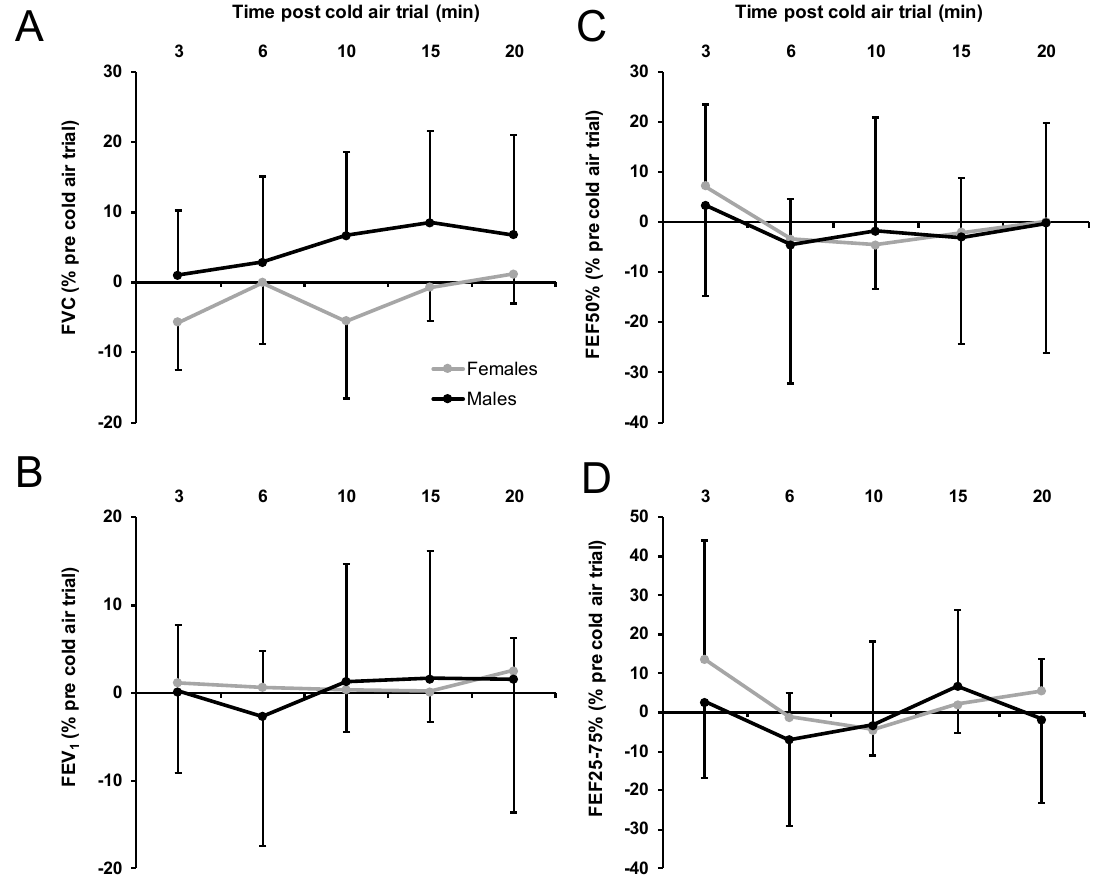
Figure 3. Acute respiratory recovery variables at 0 °C FVC ( A ), FEV 1 ( B ), FEF50% ( C ), FEV25–75% ( D ) expressed as % from pretrial values separately for females and males. Negative values show a decrease from pretrial values. FVC, forced vital capacity; FEV 1 , forced expiratory volume in 1 second; FEF50%, forced expiratory flow at 50%, FEF25–75%, forced expiratory flow at 25–75%; error bars indicate standard deviations.